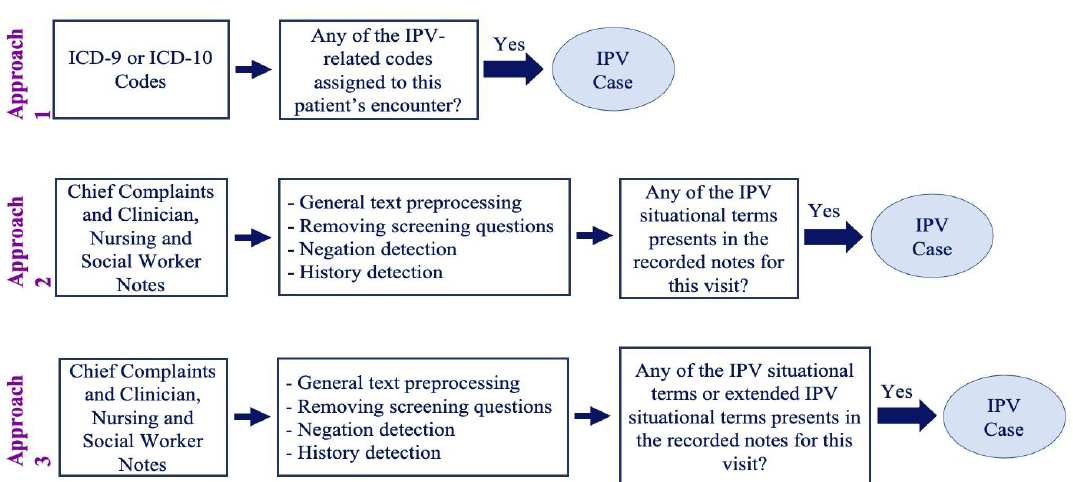
Figure 1. Summary of three methods for developing a natural language processing algorithm to identify intimate partner violence in a hospital